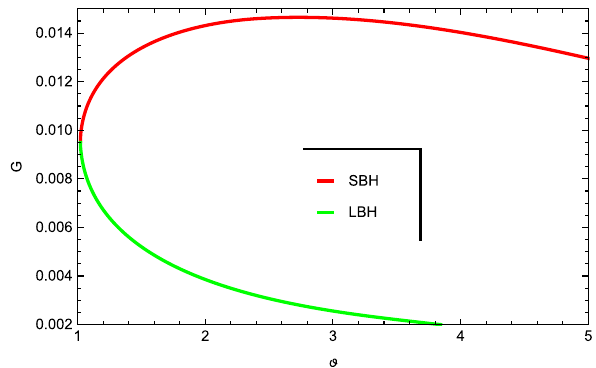
Fig. 14 PlotoftheGibbsfreeenergy G intermof ϑ for P = 0 . 04 , ζ = 0 and (cid:20) = 0 . 9